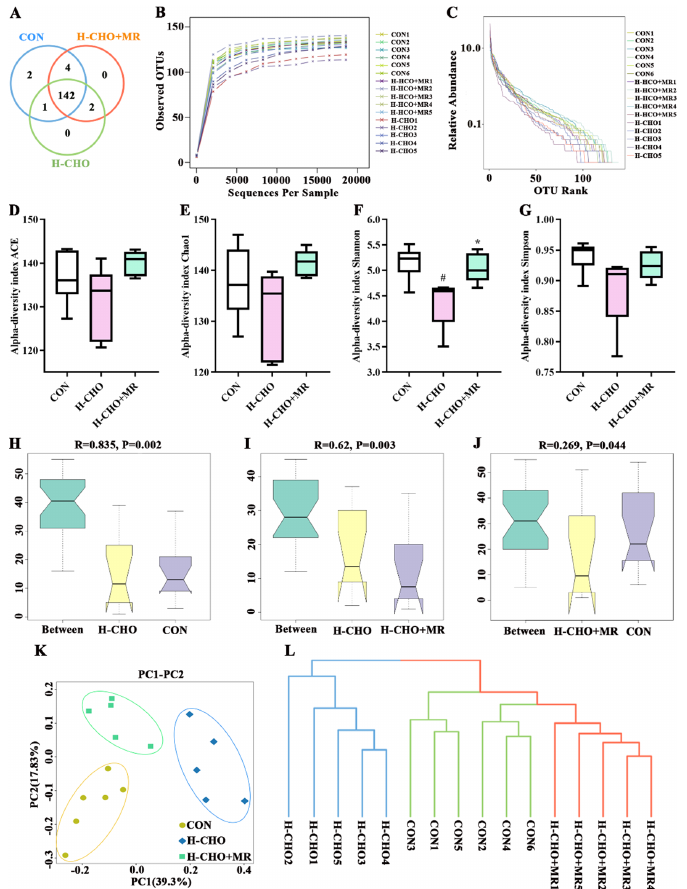
Figure 3. α -diversity analysis and β -diversity analysis of microbiota in mouse feces. ( A ) OTUs Venn analysis; ( B ) Rarefaction curve; ( C ) OTU Rank; ( D ) Ace index; ( E ) Chao1 index; ( F ) Shannon index; ( G ) Simpson index; ( H ) Anosim (H-CHO vs. CON), the closer the R value is to 1, the greater the difference between groups than the difference in the group, p < 0.05 indicates that the difference is statistically significant; ( I ) Anosim (H-CHO vs. H-CHO+MR); ( J ) Anosim (H-CHO+MR vs. CON); ( K ) PCA score plots; ( L ) unweighted unifrac cluster tree. Anosim, analysis of similarities;